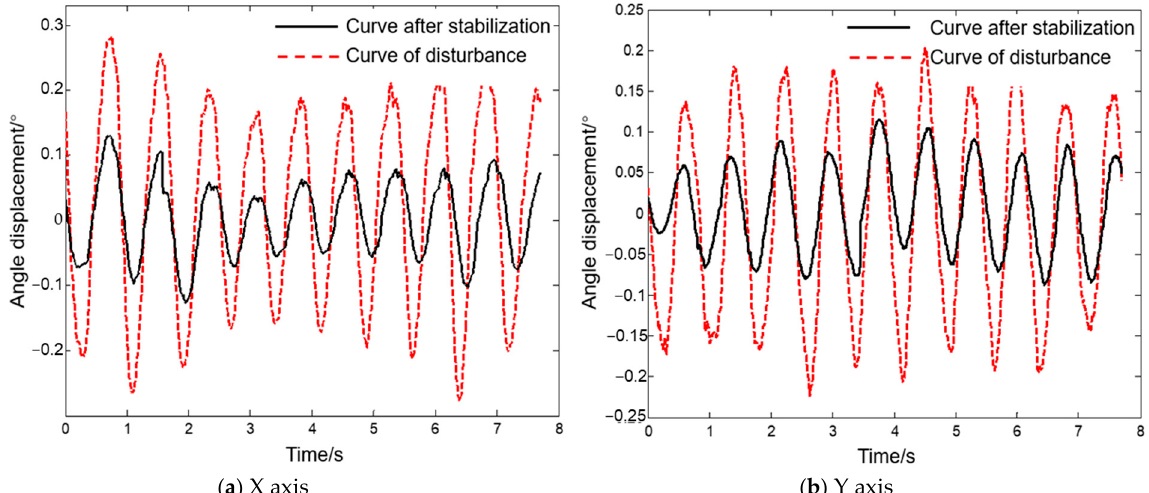
Figure 16. Attitude stability curve of the drifting platform in a free-state horizontal equilibrium position without wave disturbance.